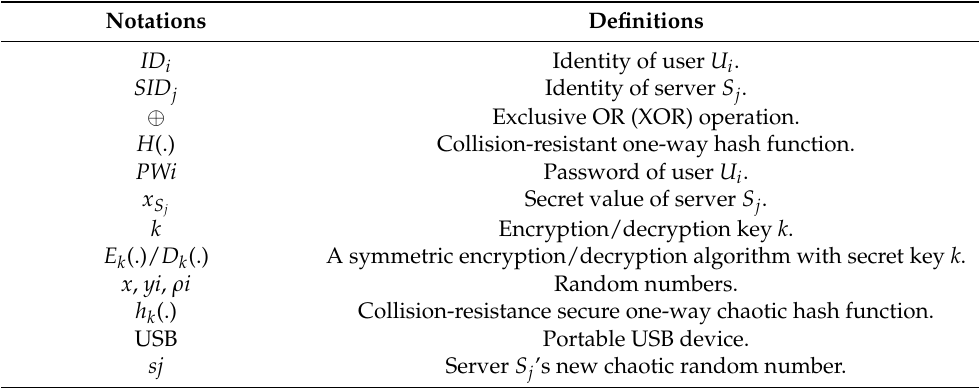
Figure 2. System structure of the proposed scheme. Table 1. Notations of the proposed scheme.